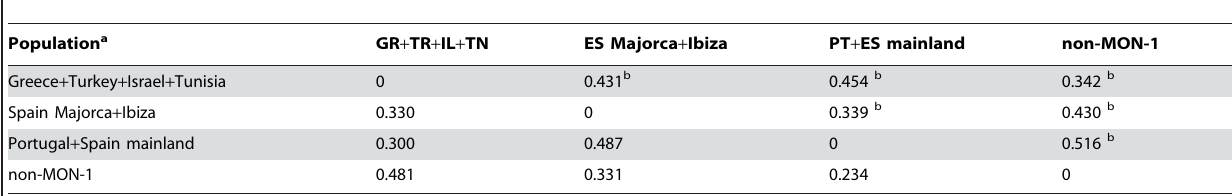
Table 6. F ST and migration rate values (Nm) values (upper and lower triangle, respectively) for the L. infantum populations